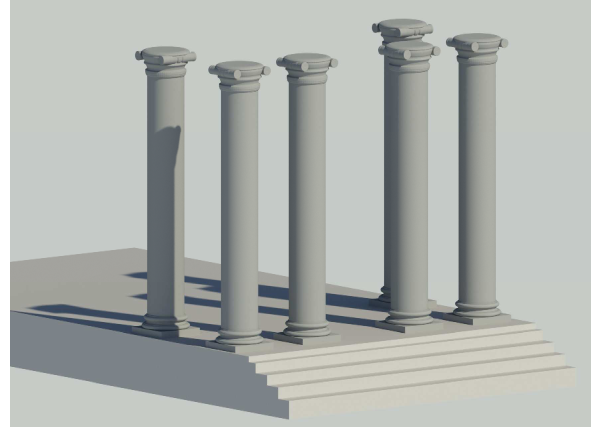
Figure 14. 3D conceptual rendering of the